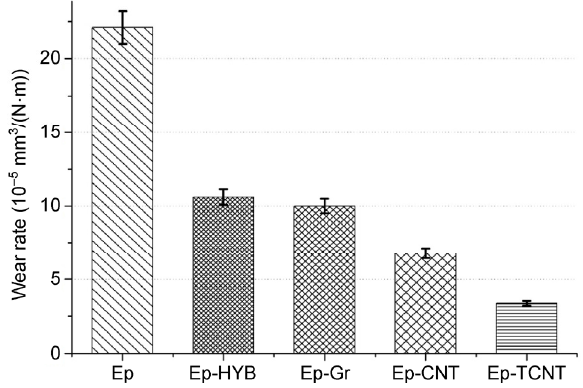
Fig. 6 Wear rate of different types of